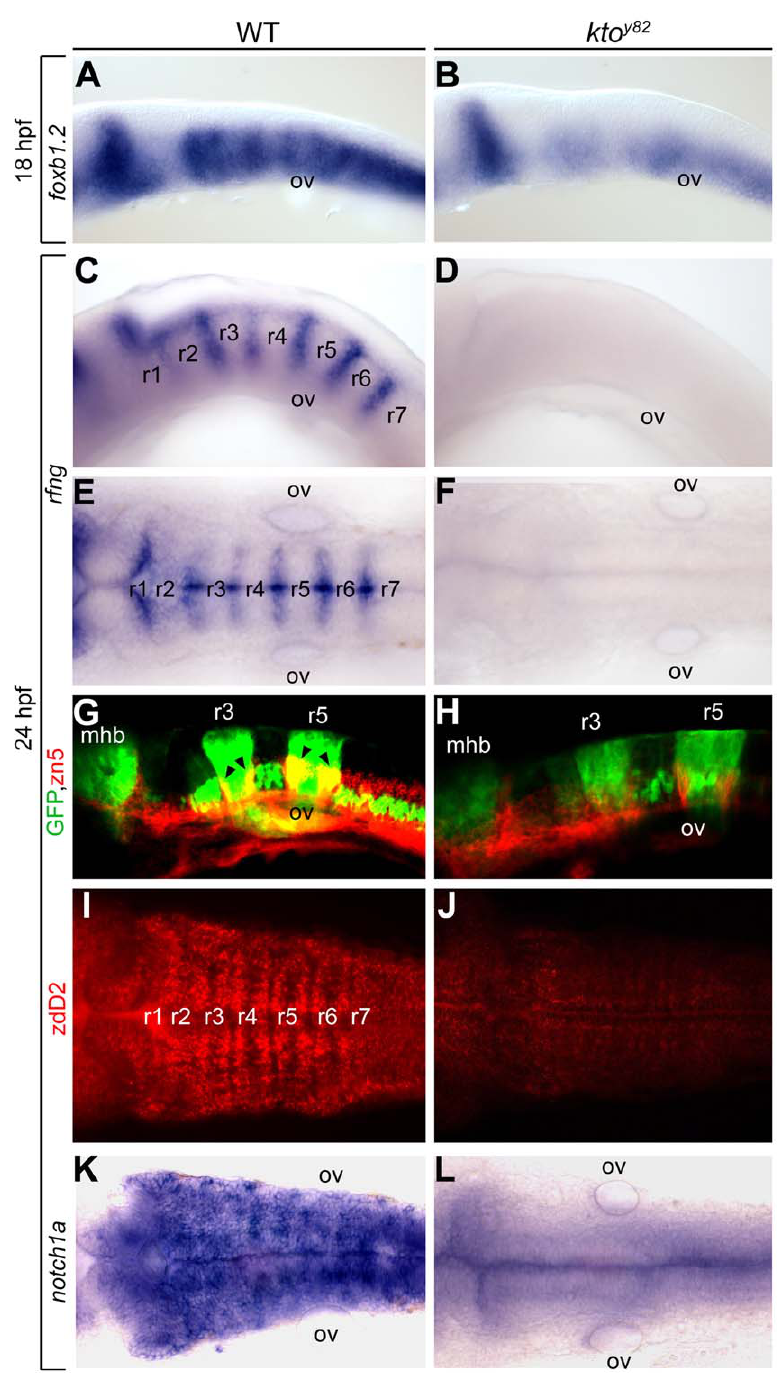
Figure 3. Specific loss of hindbrain boundaries in kto y82 mutants. Lateral (A–D,G,H) and dorsal views (E,F,I–L) of wt (A,C,E,G,I,K) and kto y82 mutant embryos (B,D,F,H,J,L) at 18 hpf (A,B) and 24 hpf (C–L). (A–F, K,L) in situ hybridization. (A,B) Expression of the earliest hindbrain boundary marker foxb1.2 . (C–F) Completely loss of rfng expression in hindbrain boundaries. (G–J) Confocal images of hindbrain boundary neurons; immunostaining with zn5 (red) in pGFP-5.3 transgenic zebrafish (green) (G,H); staining with zebrafish delta D antibody, zdD2 (I,J). (K,L) notch1a expression in the hindbrain. mhb, mid-hindbrain boundary; ov, otic vesicle; r, rhombomere.